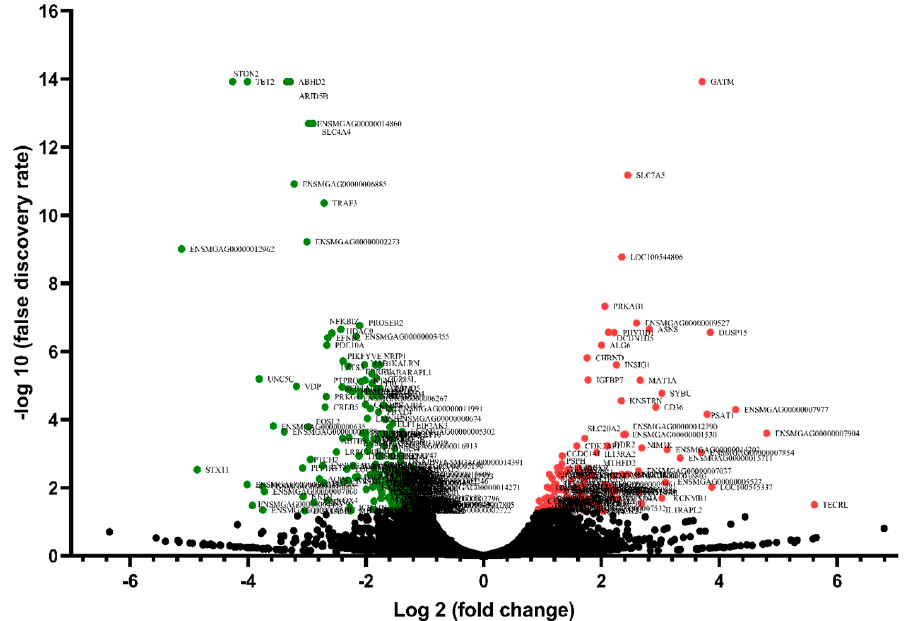
Figure 2. The volcano plot indicates the − log10 ( p -value) for genome-wide genes ( y -axis) plotted against their respective log2 (fold change) ( x -axis). Red dots represent up-regulated genes and green dots represent down-regulated genes.